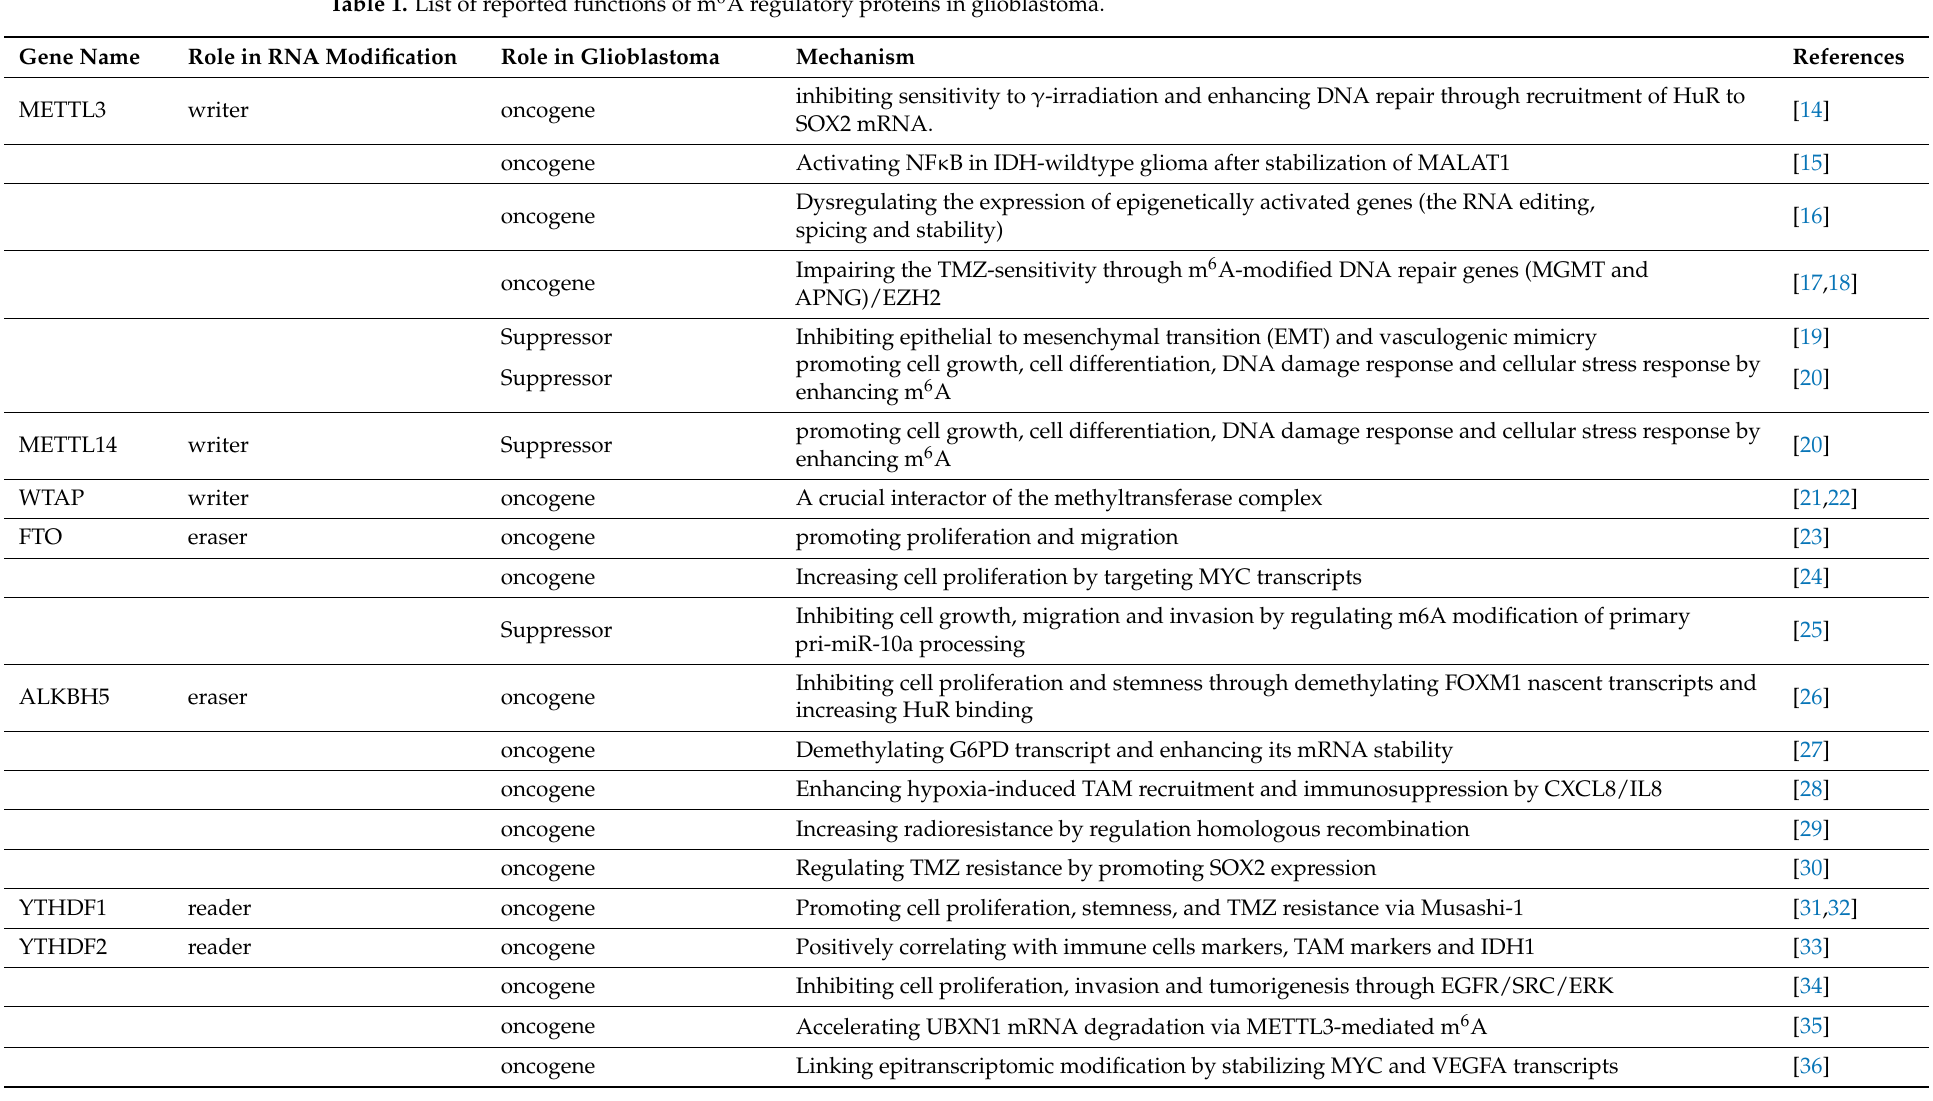
Table 1. List of reported functions of m 6 A regulatory proteins in